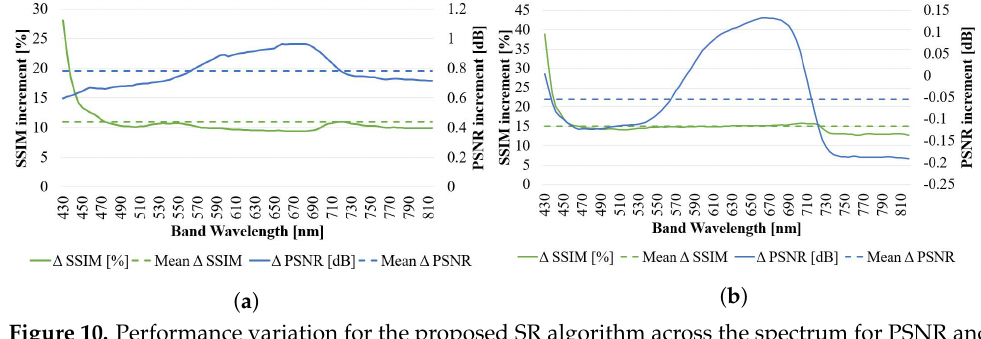
Figure 10. Performance variation for the proposed SR algorithm across the spectrum for PSNR and SSIM metrics in Sequence 1 : ( a ) EF = 2 (N = 8) and ( b ) EF = 4 (N = 24). Average values are presented in dashed lines.